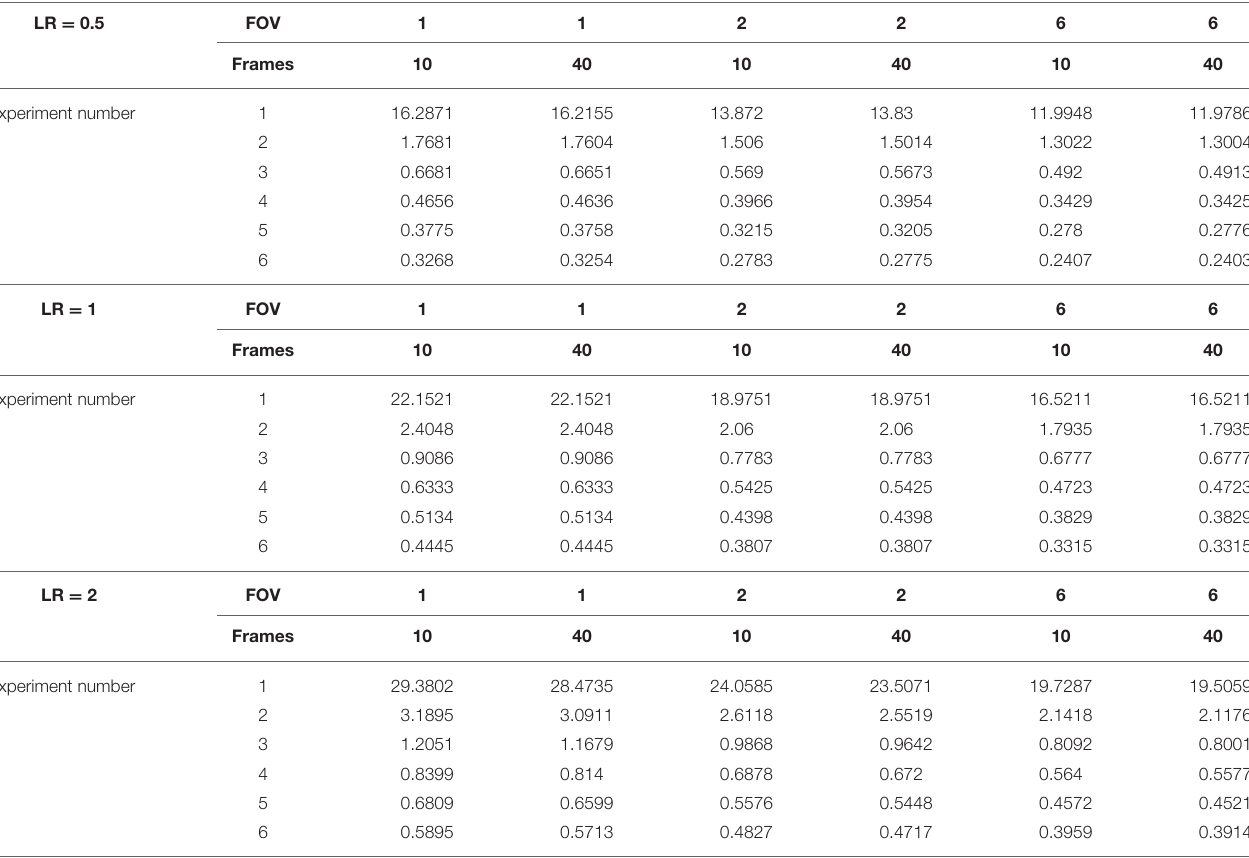
TABLE 3 | Expected margin of error (MOE) for a 1-sided 95% confidence interval for the mean log reduction in GFP area at a variety of experimental parameters and when LR = 0.5 (i.e., when percent reduction is 68%), when LR = 1 (i.e., when percent reduction is 90%), and when LR = 2 (i.e., when percent reduction is 99%). LR =